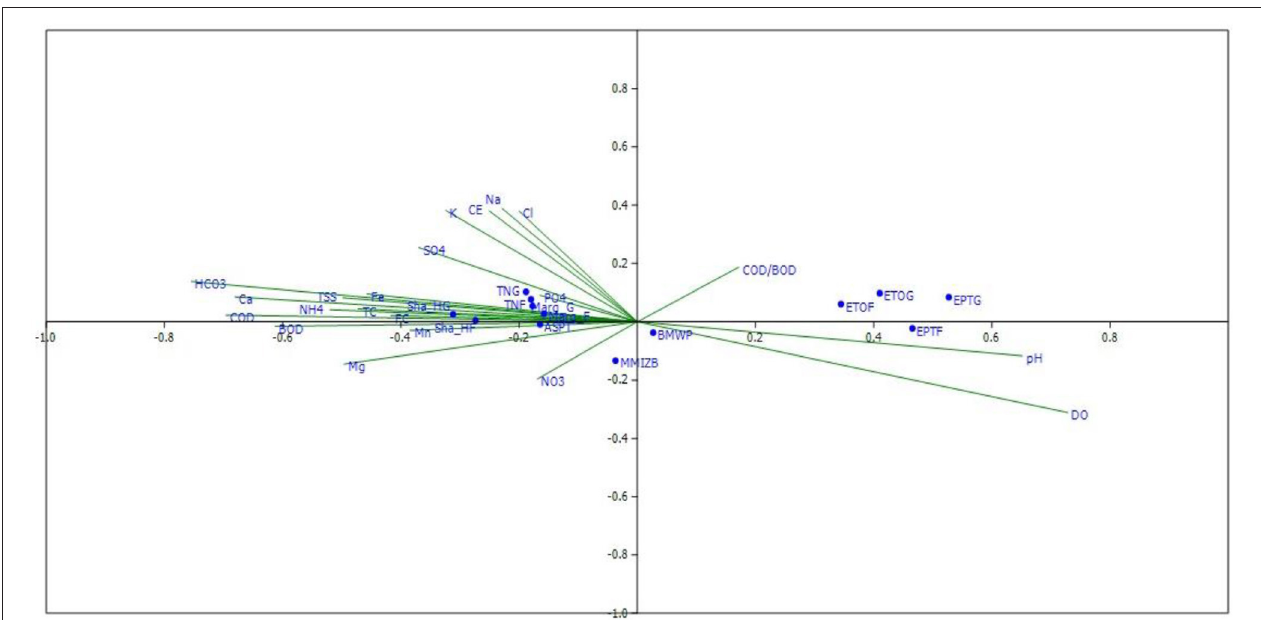
FIGURE 4 | A canonical correspondence analysis (CCA) biplot showing the association between water quality parameters and macroinvertebrate